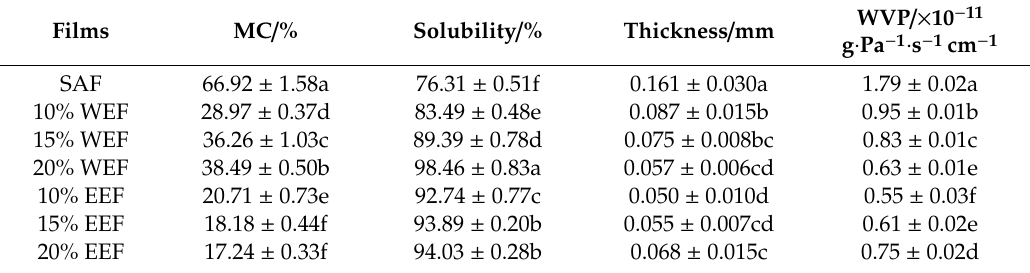
Table 3. Moisture content, water solubility, thickness and water vapor permeability of the